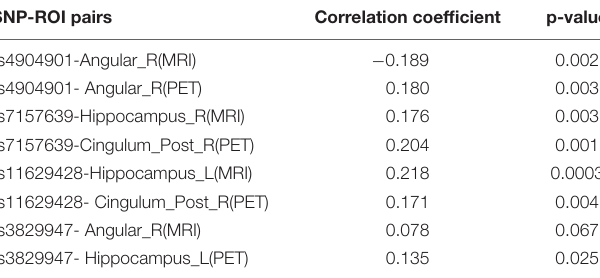
TABLE 6 | The correlation coefficients and p-values of eight SNP-ROI pairs. SNP-ROI